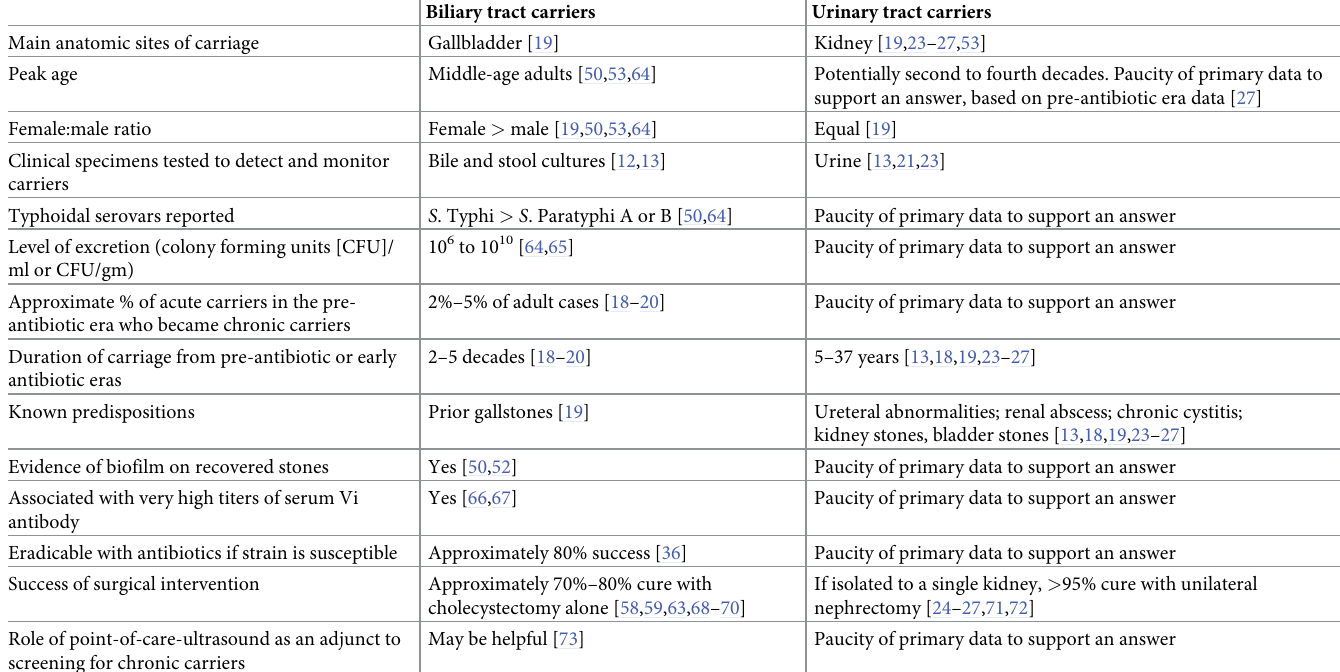
Table 1. Comparison of reported and unknown features of biliary versus urinary